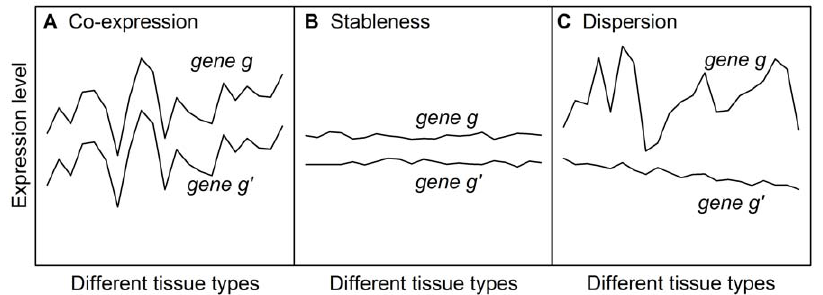
Figure 3. Schematic illustration of the three factors that contribute to preserve gene expression rankings. The three factors represent three different types of expression pattern of a pair of genes in different tissues: (A) Co-expression ( r gg 9 ; Equation (5) ), (B) stableness ( S gg 9 ; Equation (7) ), and (C) dispersion ( D gg 9 ; Equation (8) ).